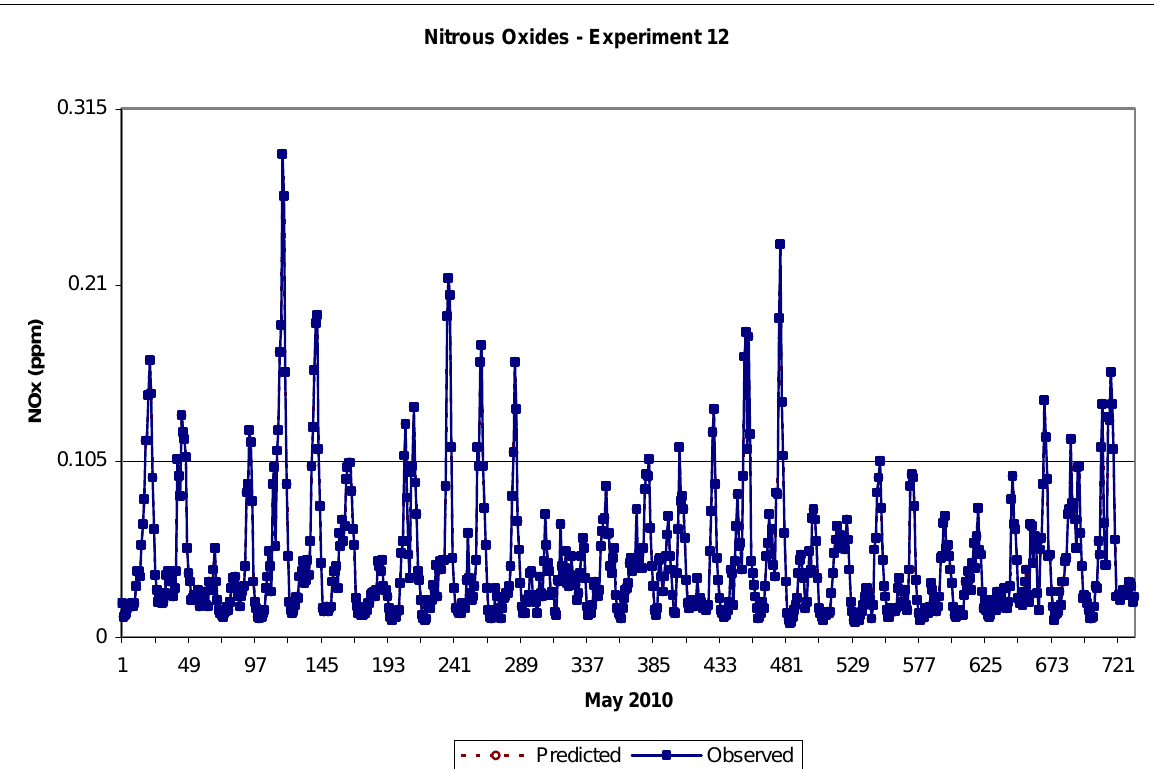
Fig. 4. Experiment 12 results: predicted vs observed time